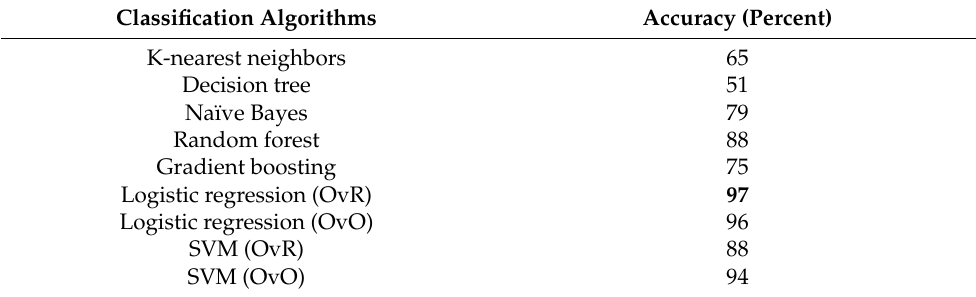
Table 6. Multimodal recognition accuracy comparison on different